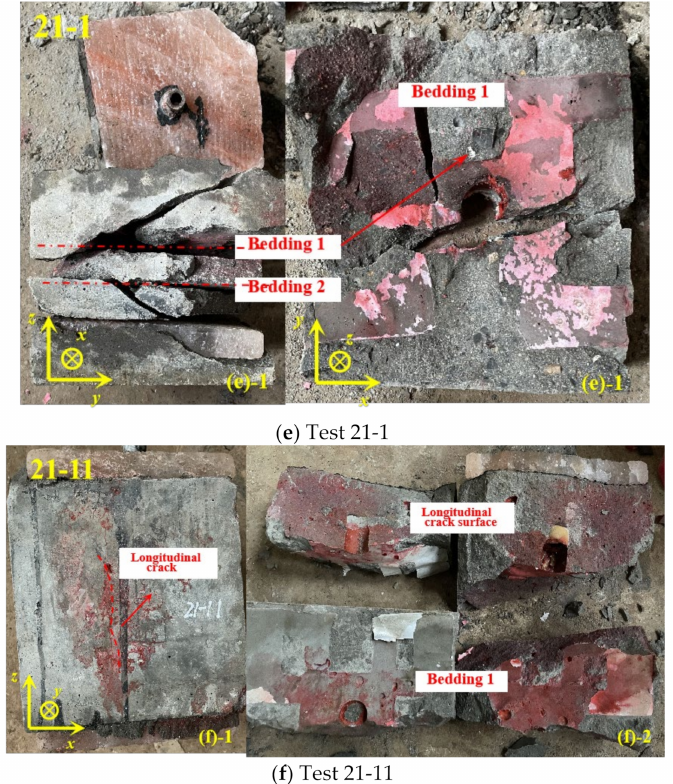
Figure 11. Basic fracture modes of